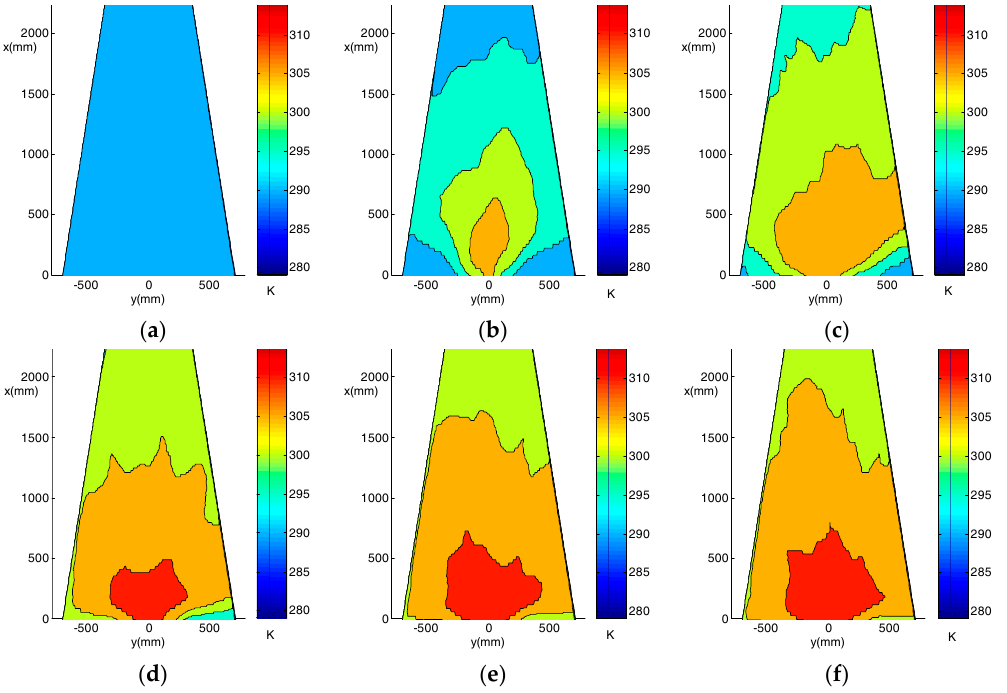
Figure 4. Thermal images for discharge inside a stagnant environment. ( a ) t = 0 s; ( b ) t = 20 s; ( c ) t = 40 s; ( d ) t = 60 s; ( e ) t = 80 s; ( f ) t = 100 s.